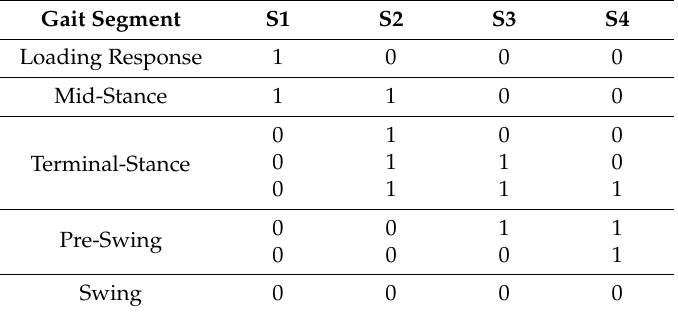
Table 1. Sensor states during different phases of gait.